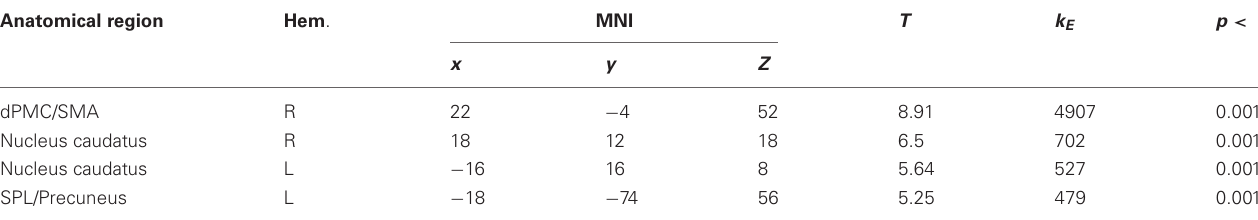
Table 2 | Motor imagery contrast (MI) at T1. Anatomical region